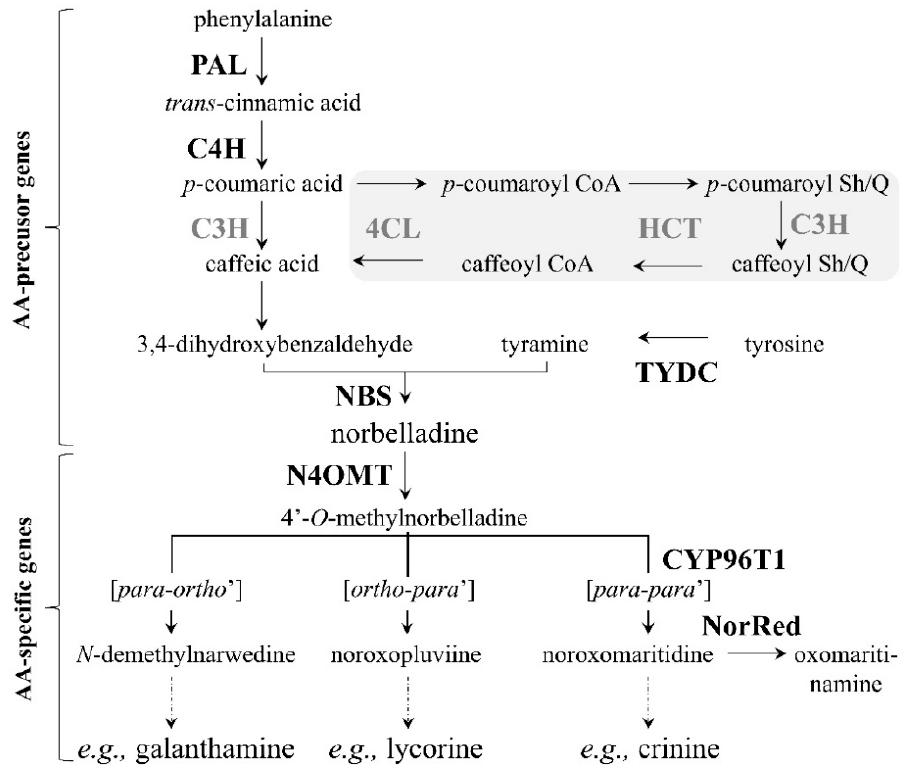
Figure 1. Proposed Amaryllidaceae alkaloid biosynthetic pathway. Abbreviations of enzymes for which corresponding genes have been isolated from Amaryllidaceae plants are written in bold-black font, whereas those isolated from other plants are written in bold-grey font. Reactions in the grey-shaded area represent an alternative route for caffeic acid synthesis. Broken arrows represent more than one biochemical reaction. Abbreviations: PAL, phenylalanine ammonia lyase; C4H, cinnamate 4-hydroxylase (CYP73A1); 4CL, 4-coumarate CoA ligase; HCT, hydroxycinnamoyl transferase; C3H, coumarate 3-hydroxylase (CYP98A3); TYDC, tyrosine decarboxylase; NBS, norbelladine